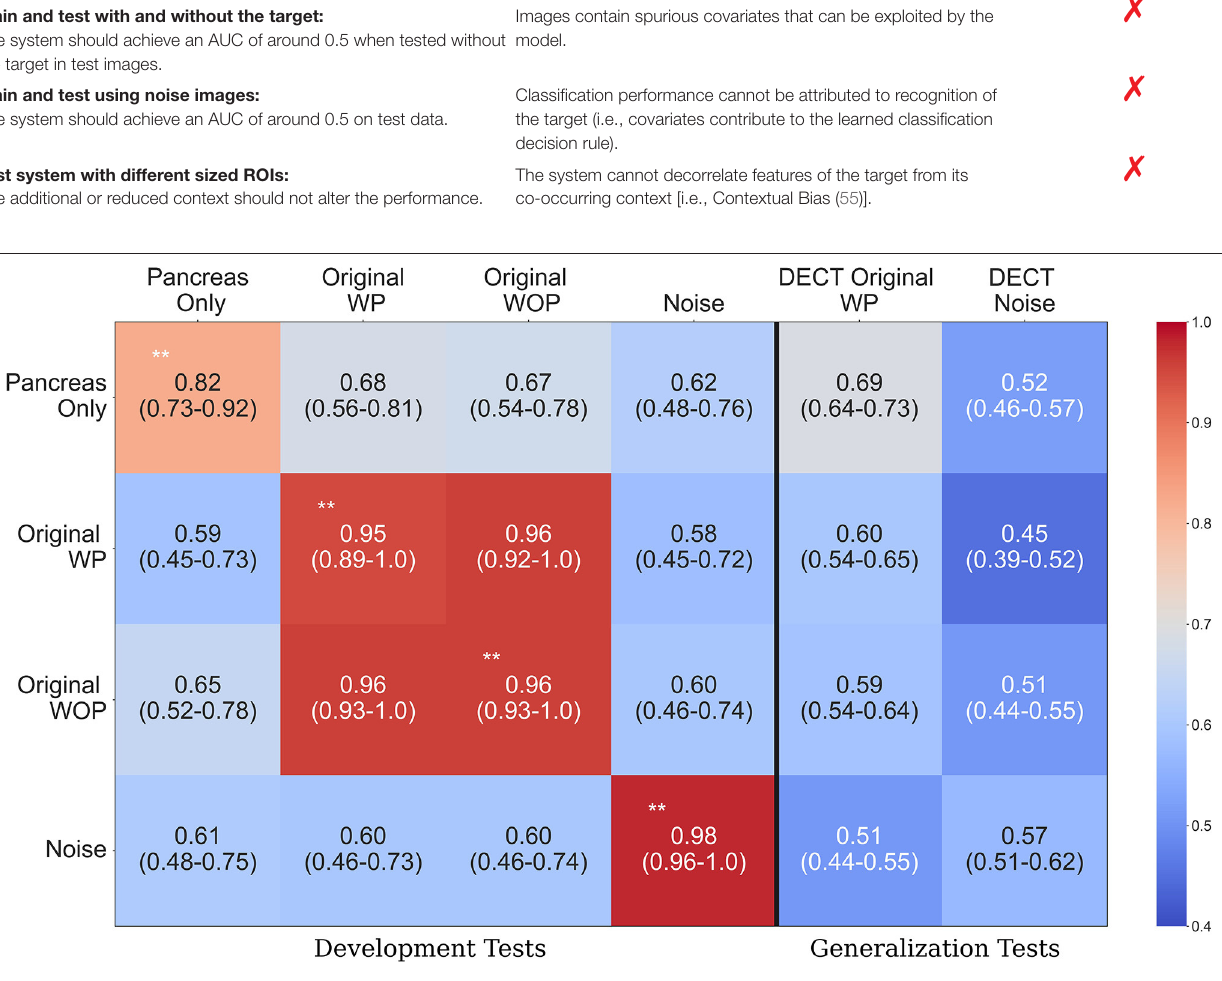
TABLE 2 | The proposed sanity tests to assess the reliability of medical AI systems. Sanity test Implications of failing the test Does CTNet pass the test? Train and test with and without the target: The system should achieve an AUC of around 0.5 when tested without the target in test images.